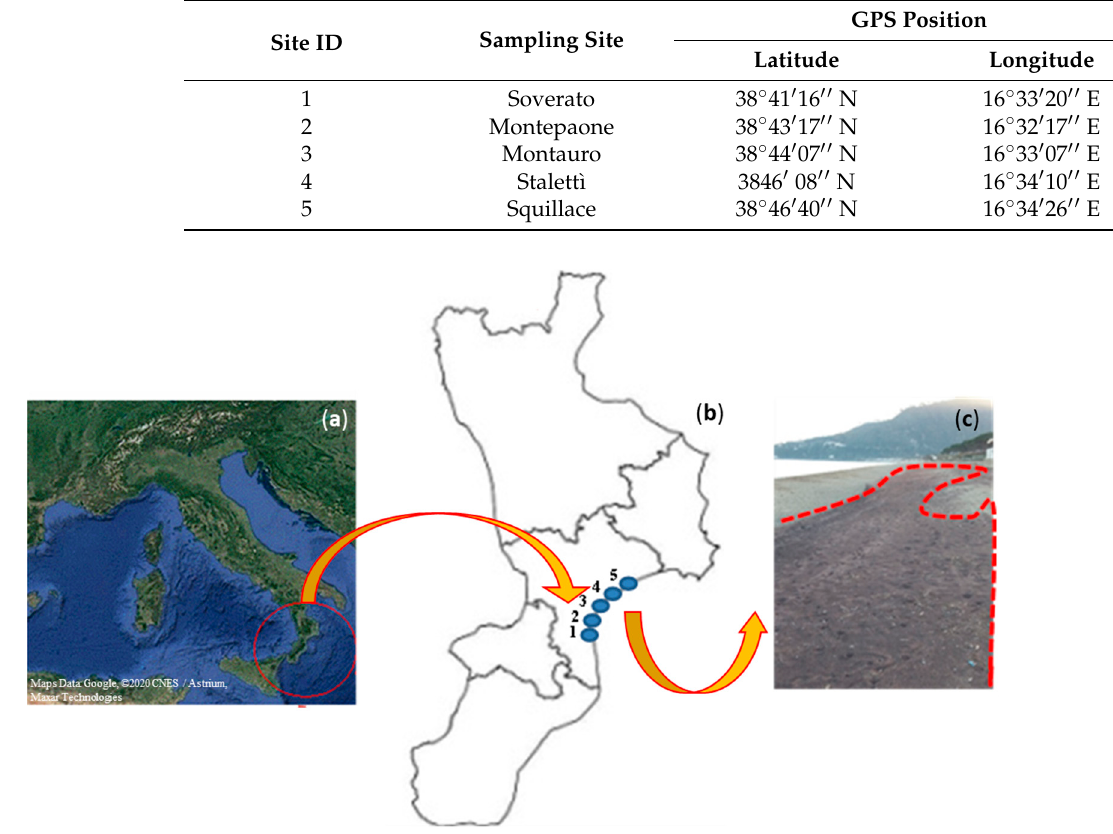
Figure 1. The map of the investigated area ( a ), with the site IDs (1–5) ( b ) and a typical image of the particular reddish sand ( c ) reported.